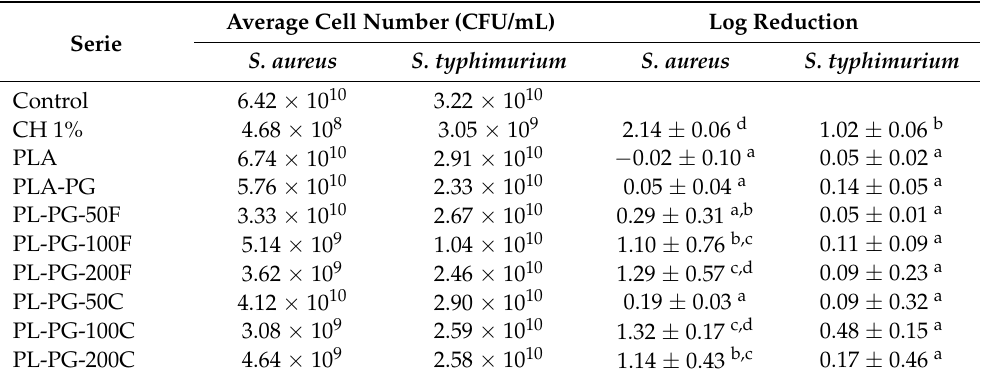
Table 5. Bacterial growth after 24 h of incubation for the microorganisms S. aureus and S. typhimurium on PLA films made with chitosan. Average Cell Number (CFU/mL) Log Reduction Serie S. aureus S. typhimurium S.